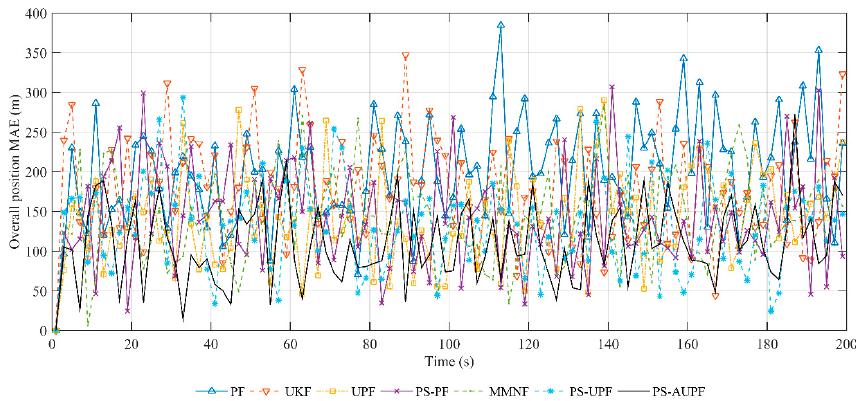
Figure 7. The mean absolute error (MAE) distribution of the estimated target position.